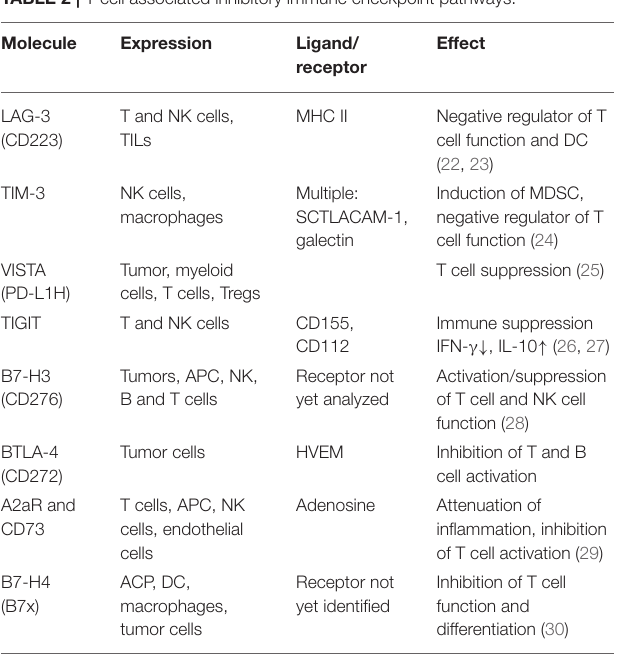
TABLE 2 | T cell associated inhibitory immune checkpoint